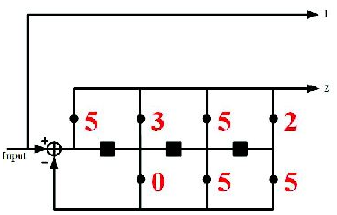
η = 5.42. Figure 7. 7-Ary, constraint length = 4, η = 5.42. η = 5.42.